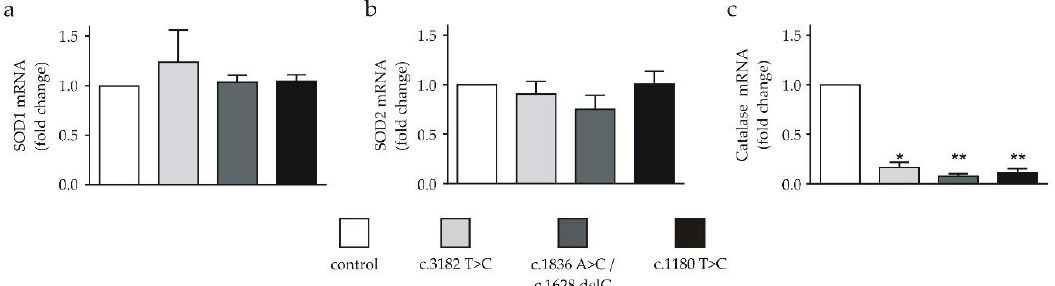
Figure 2. mRNA expression of SOD1, SOD2 and catalase in neuronal differentiated cells. ( a ) SOD1 mRNA and ( b ) SOD2 mRNA expressions in NPC1-deficient cell lines were not different in comparison to the control ( n = 5 or 6). ( c ) All NPC1-deficient cell lines showed a significantly lower expression of catalase mRNA ( n = 6). * = p < 0.05 and ** = p < 0.01. Statistical tests used: ( a – c ) one-way ANOVA with Kruskal-Wallis multiple comparisons test. See also the Materials and Methods section.